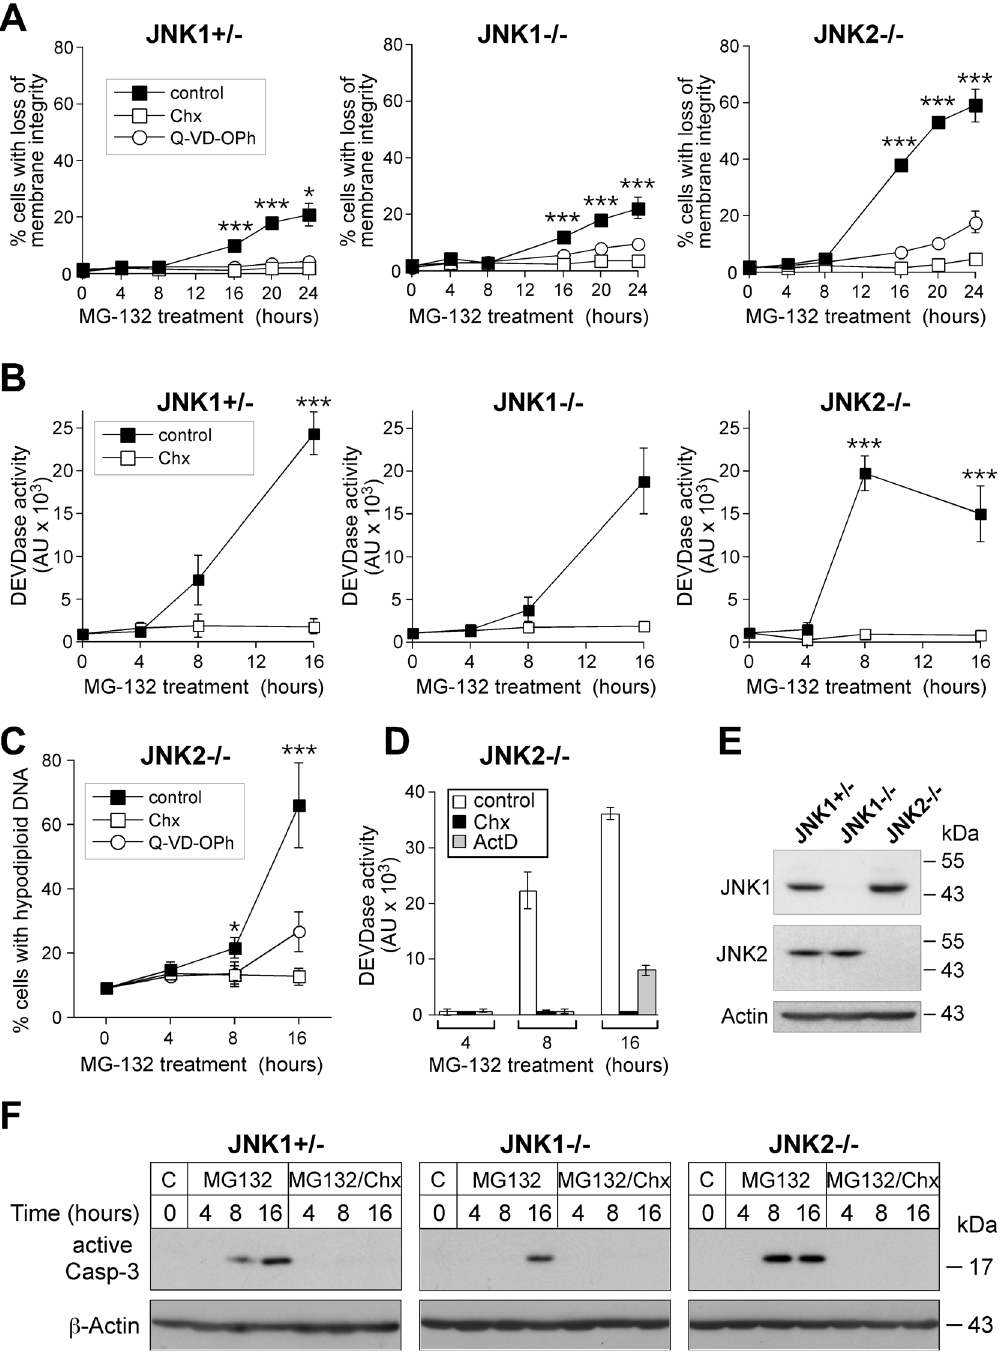
Figure 1. Rapid induction of apoptosis by MG-132 only in JNK2 2 / 2 cells. The three MEF lines were exposed to MG-132 for the indicated times in the absence or presence of Chx, ActD or Q-VD-OPh. Cell death was determined either cytometrically by quantification of propidium iodide- stained cells ( A ) and hypodiploid nuclei ( C ), or by fluorometric assessment of caspase-3-like DEVDase activities ( B , D ). Values represent the mean of three ( A–C ) and two ( D ) independent experiments + / 2 SD. ( E ) Extracts of the indicated MEF lines were analyzed by Western blotting for their JNK status using the detection of b -Actin as loading control. ( F ) Western blots showing the status of active caspase-3 and b -actin in extracts of the three MEF lines treated as indicated. One representative experiment out of three is shown. For all panels, * p , 0.05; *** p , 0.005 according to ANOVA Tukeys test in a time-matched comparison of cells that were treated with MG-132 alone vs. cells treated with MG-132 in the presence of Chx or Q-VD- OPh, respectively.